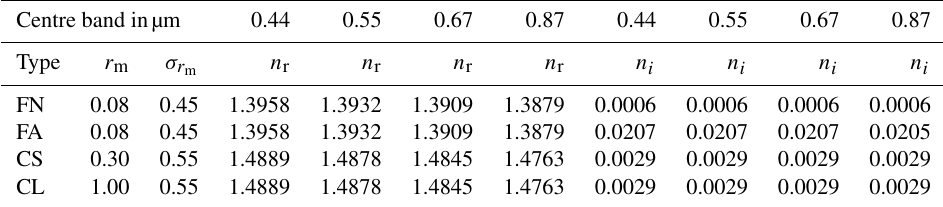
Table 3. Microphysical parameter values for the four vertices (FA, FN, CS and CL) in the selected spectral bands. Radius are given in µm. Centre band inµm